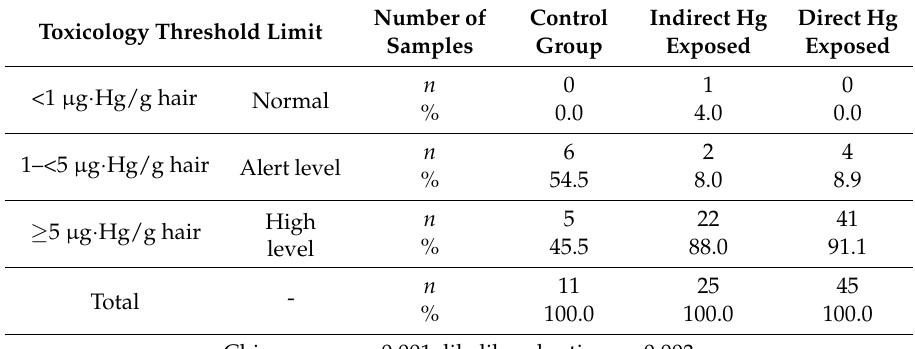
Table 3. Laboratory data based Human Biomonitoring (HBM) categories. Number of Toxicology Threshold Limit Samples